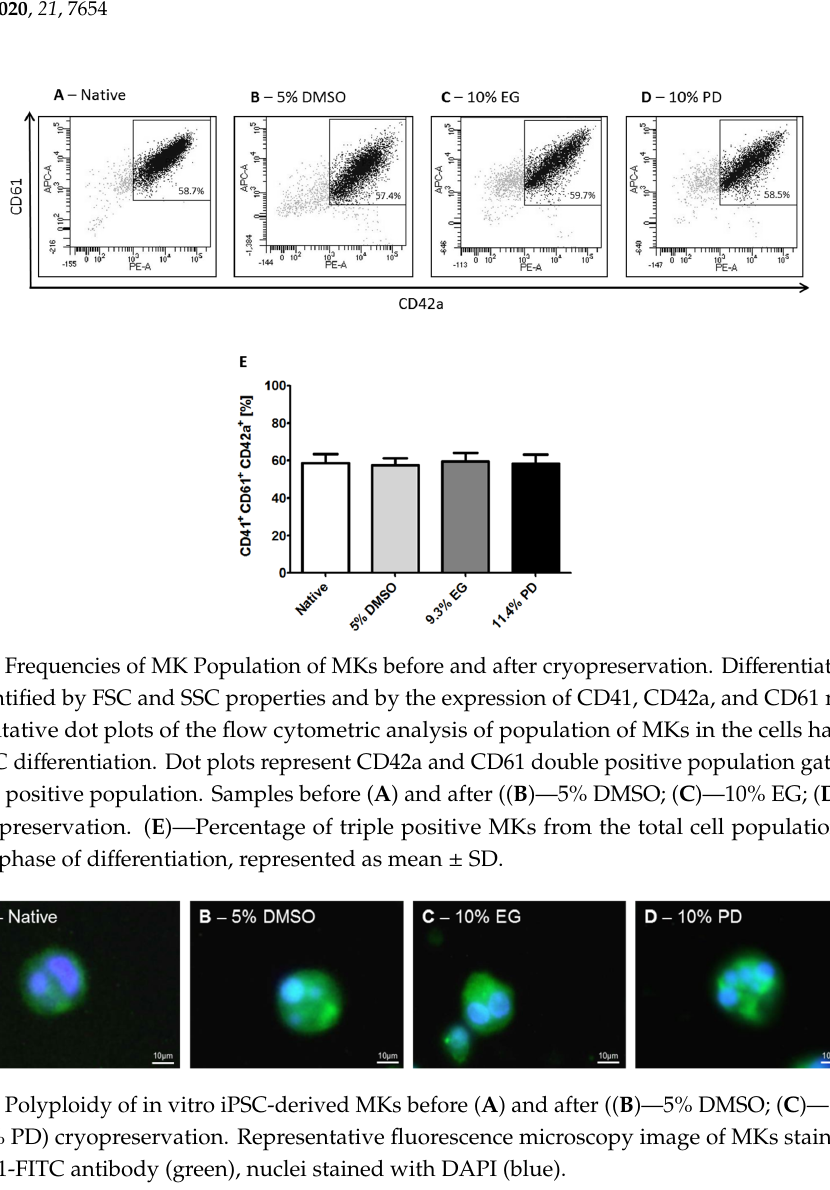
Figure 4. Polyploidy of in vitro iPSC-derived MKs before ( A ) and after (( B )—5% DMSO; ( C )—10% EG; ( D )—10% PD) cryopreservation. Representative fluorescence microscopy image of MKs stained